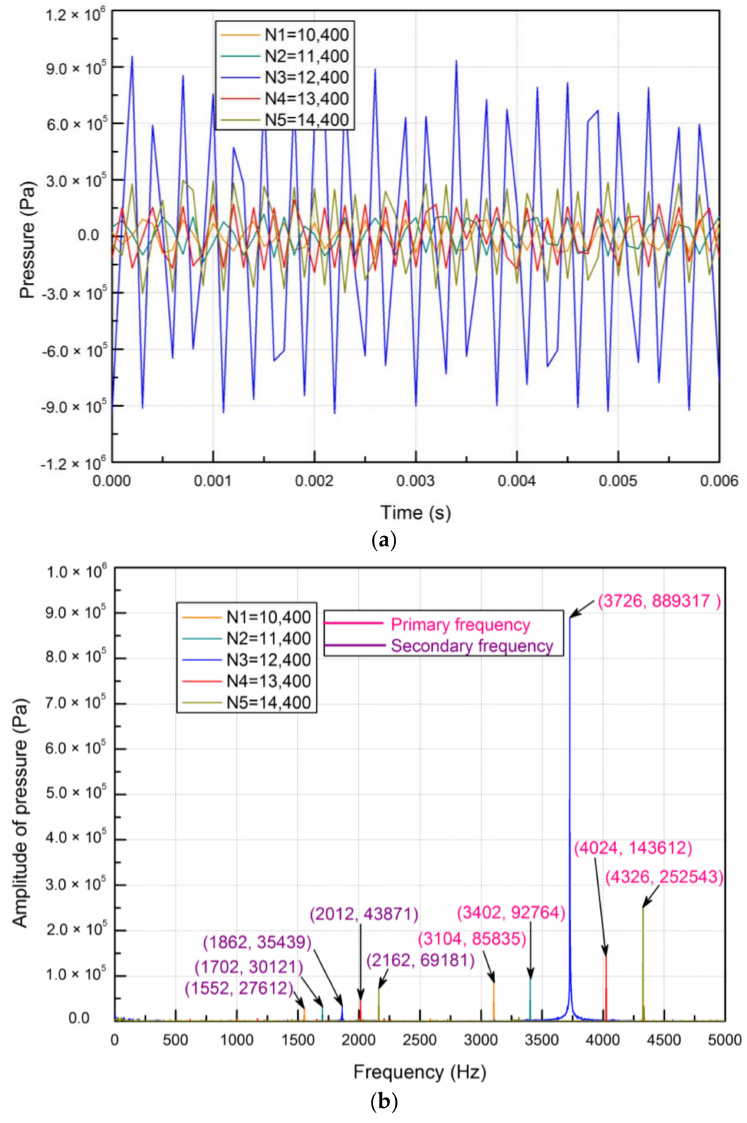
Figure 9. Characteristics of the pressure pulsations at P2 for the Type A flapper-armature assembly: ( a ) in the time domain; ( b ) in the frequency